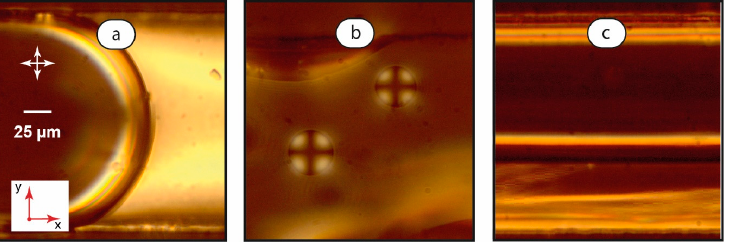
Figure 4. Interfacial boundaries between LC and aqueous phases: microchannel-wide droplets, U = 0.1 mm/s ( a ); smaller droplets immobilized on the bottom wall of the microchannel, U = 0.1 mm/s ( b ); and LC-water thread, U = 2 mm/s ( c ). Red arrows demonstrate coordinate axes with respect to Figure 1. Crossed white arrows indicate positions of polarizers.